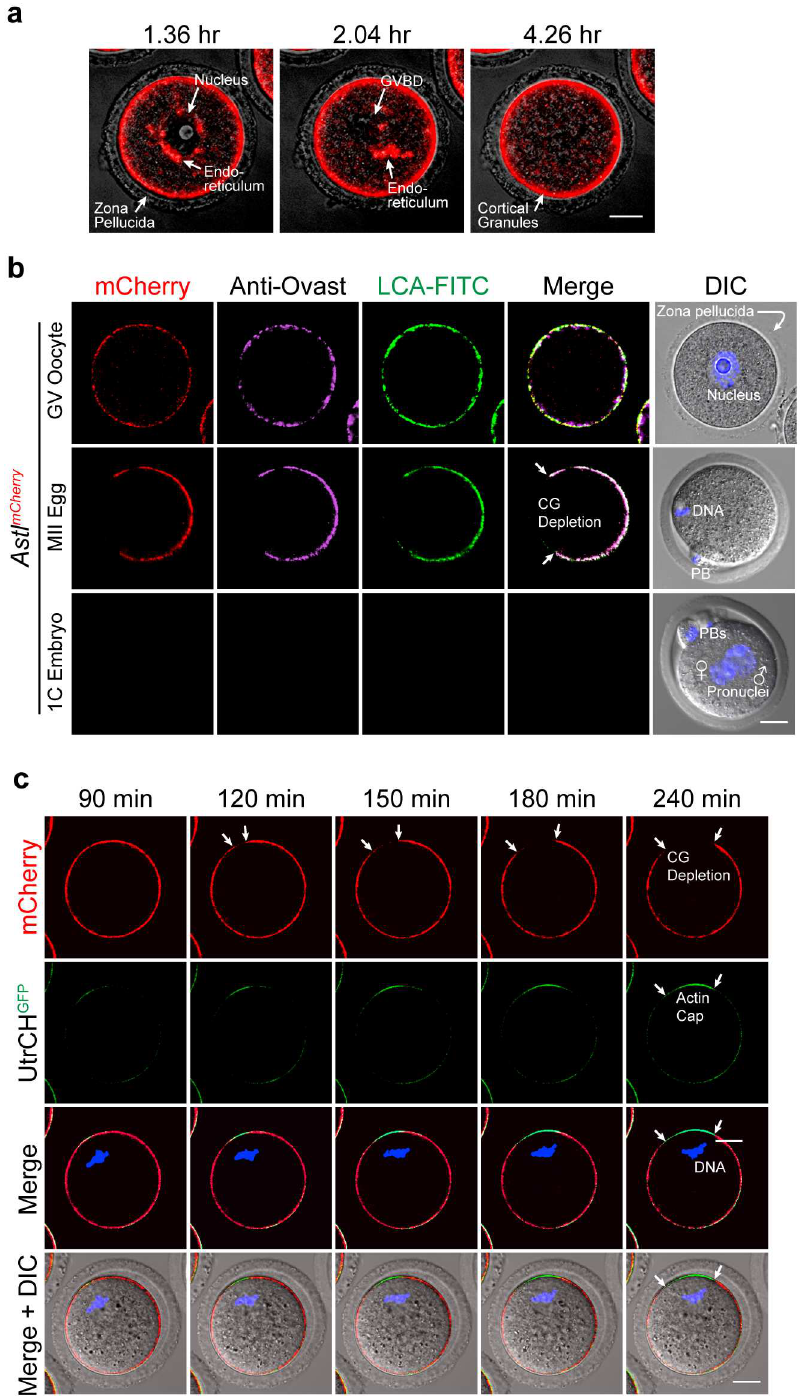
Fig 2. Localization of Astl mCherry to cortical granules in transgenic mice. (a) Oocytes (70–75 μ m) were isolatedfrom Astl mCherry transgenic mice and imagedin an environmental chamber(37˚C, 5% CO 2 ) by confocalmicroscopy duringgerminalvesicle (nucleus) breakdown(GVBD). (b) GV-intact oocytes (upper), ovulatedmetaphaseII (MII) eggs (middle)and one cell (1C) embryos (lower) from Astl mCherry transgenicmice were permeabilized,stained with antibody to ovastacin and with LCA-FITC to localize cortical granulesand imagedwith confocal and DIC microscopy. CG, cortical granule;PB, polar body. Scale bar, 20 μ m. (c) GV- intact oocytes from Astl mCherry transgenicmice were injected with cRNA encoding UtrCH GFP